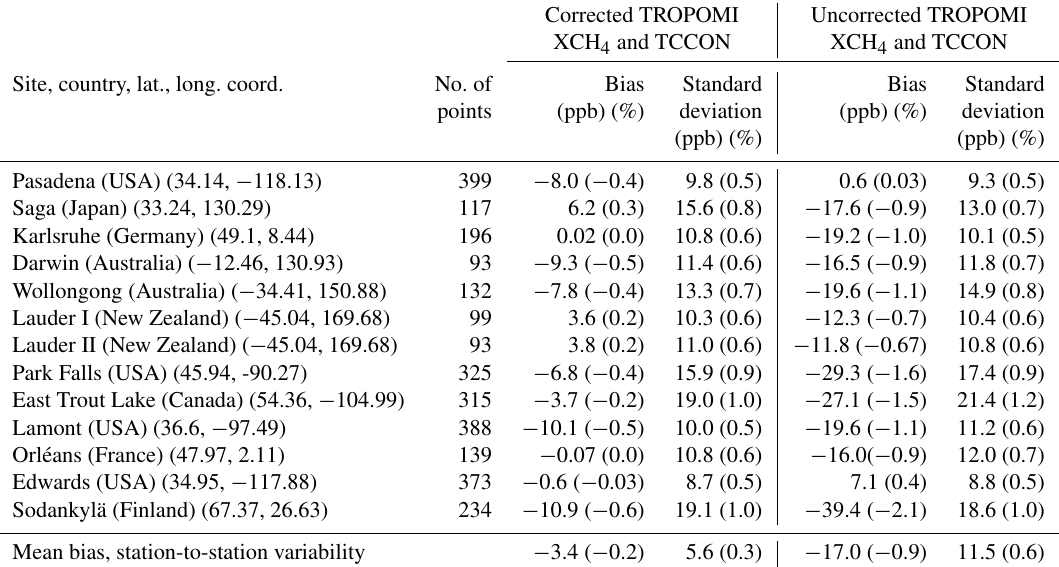
Table 3. Overview of the validation results of TROPOMI XCH 4 with measurements from TCCON at selected stations. The table shows the number of collocations, mean bias and standard deviation for each station and the mean bias for all stations and the station-to-station variability (in ppb and in percentages between parenthesis). Results are shown for TROPOMI XCH 4 with and without the albedo bias correction applied. Corrected TROPOMI Uncorrected TROPOMI XCH 4 and TCCON XCH 4 and TCCON Site, country, lat., long.